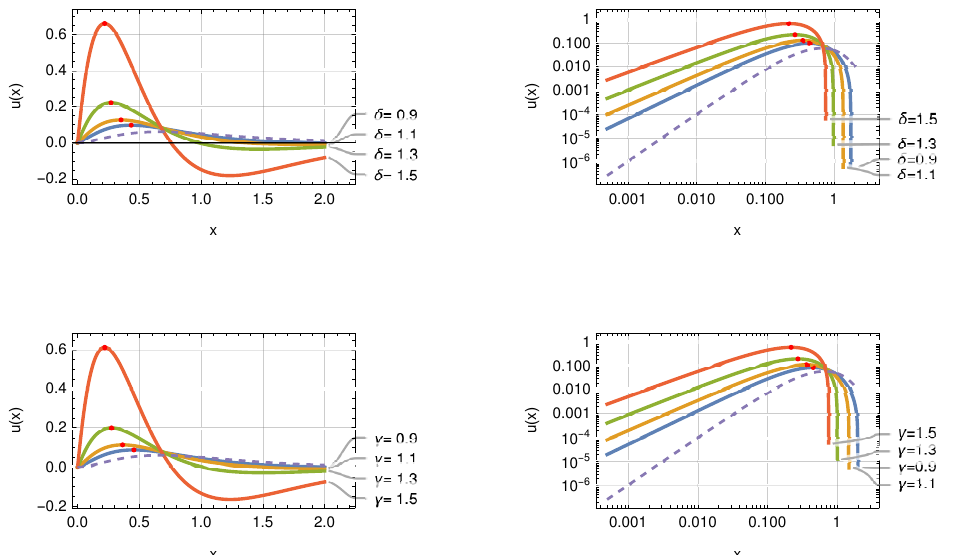
Figure 15. Variation of parameters (indicated in the panels) for the convolution integral (56) using ( − x ) = ˜ E ( − x ) based on ℵ functions. The parameters are a weighted Mittag-Leffler function E δ , γ α , β α , β α = 1/3 and β = 1/2. The top row uses γ = 2 and the bottom row δ = 2. The number of Sinc points in all approximations is N = 48. The inhomogeneity used is f ( x ) = x 2 exp ( − 3 x ) (dashed line).